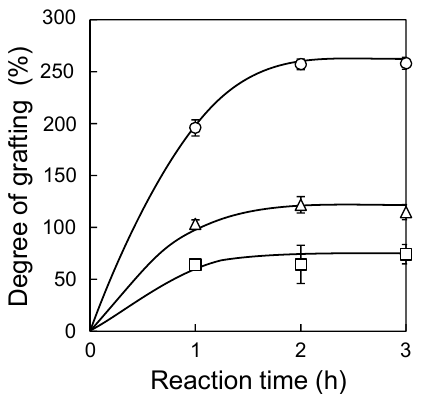
Figure 4. Graft polymerization using the SREG method at 20 ( ○ ), 10 ( △ ), and 5 ( □ ) kGy. Error bars indicate standard deviation.